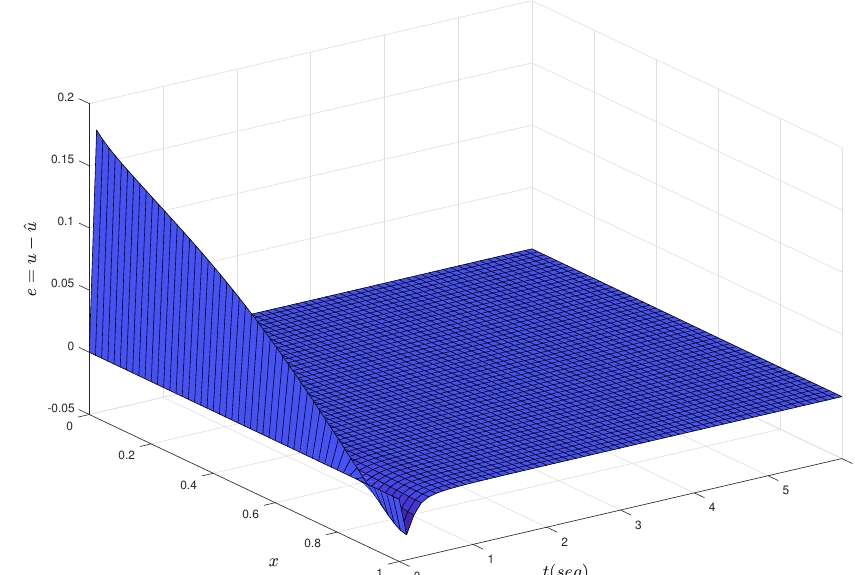
Figure 4. Convergence to zero of the estimation error.